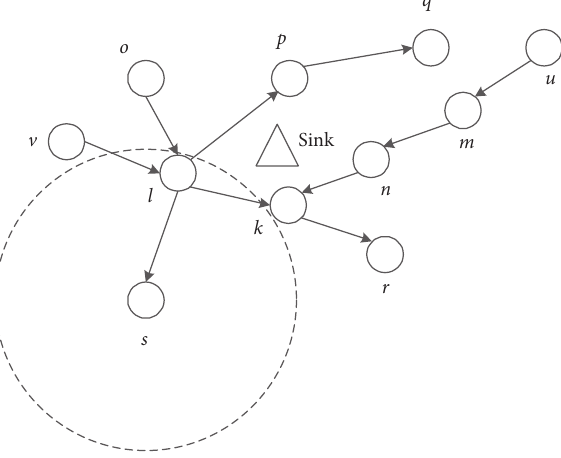
Figure 2: Process of data gathering with random